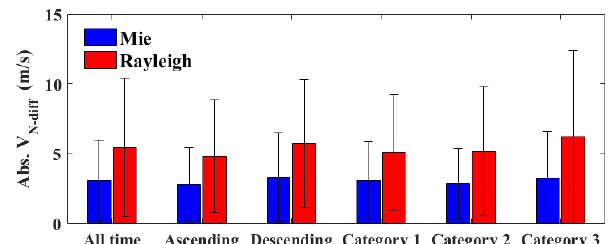
Figure 12. Absolute normalized differences between Aeolus HLOS and RWP HLOS wind speeds for Mie-cloudy winds (blue bar) and Rayleigh-clear winds (red bar). The thin black range indicates a spread of absolute normalized difference standard